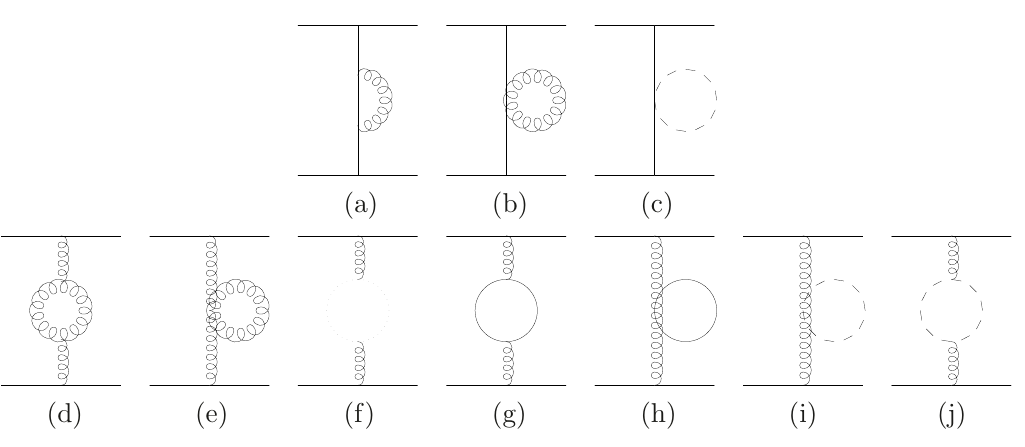
Figure 3 . One-loop self-energy diagrams contributing to δ of figure 2, dotted lines are ghosts and dashed lines are the scalars φ I